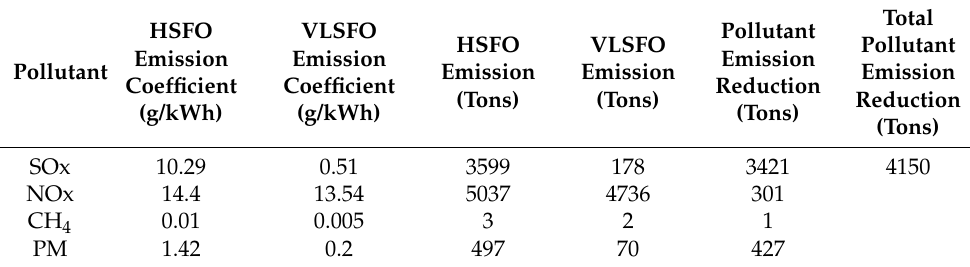
Table 13. Pollutant emission reductions of the VLSFO strategy in the first year.